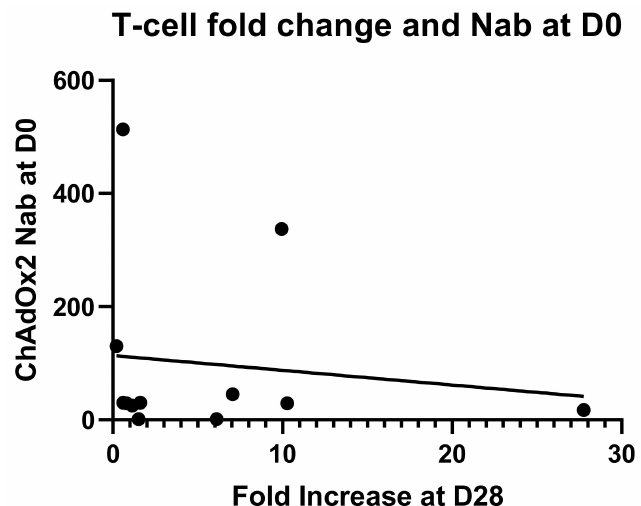
Figure 5. Linear regression for neutralising antibody titres against the vector at baseline and fold change in T-cell responses against the vaccine antigens at D28. No significant correlation has been found ( r 2 = 0.01647, p =